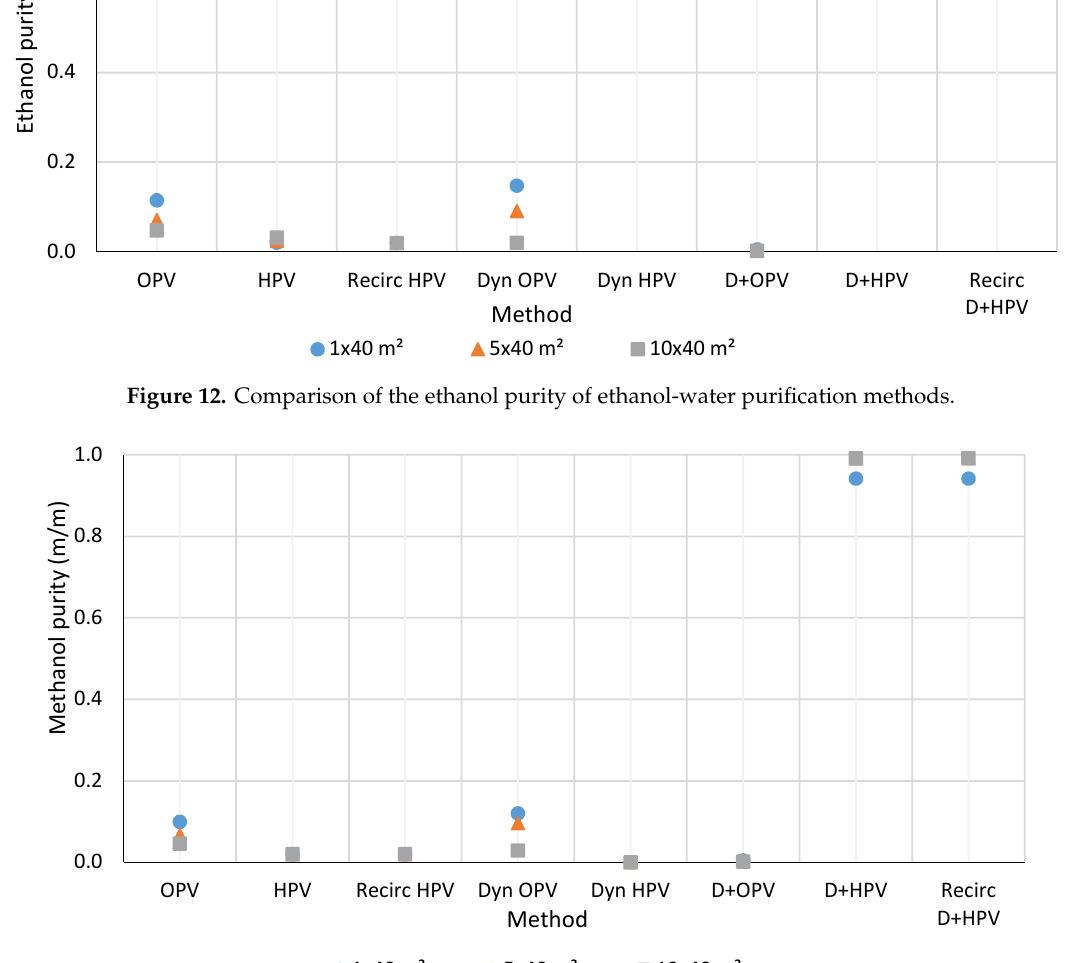
Figure 13. Comparison of the methanol purity of methanol-water purification methods.